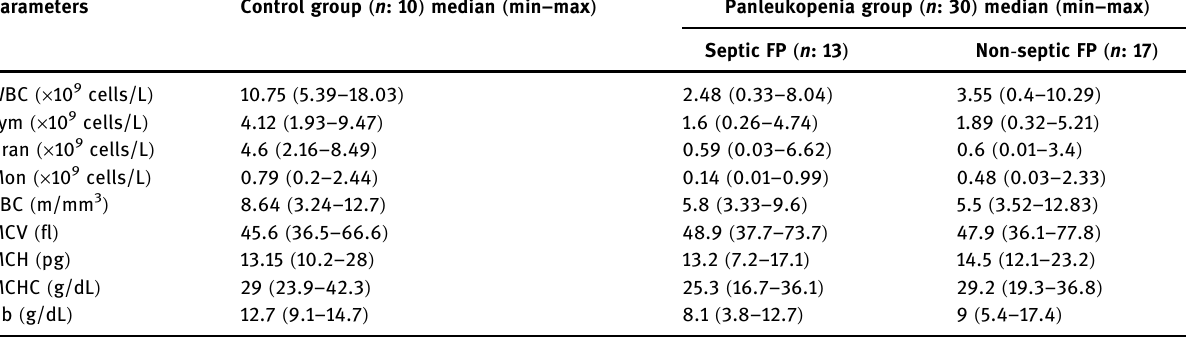
Table 4: Hemogram analysis results